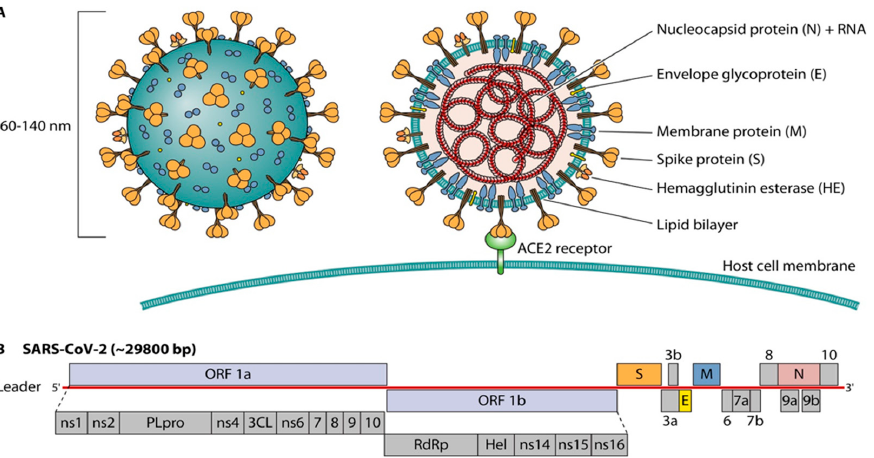
Figure 1. Structure of SARS-CoV-2 virus. A—Schematic of SARS-CoV-2 virion, B—Schematic of SARS-CoV-2 genome structure. Reprinted with permission from ref. [8]. Copyright 2021 American Society for Microbiology-Journals.